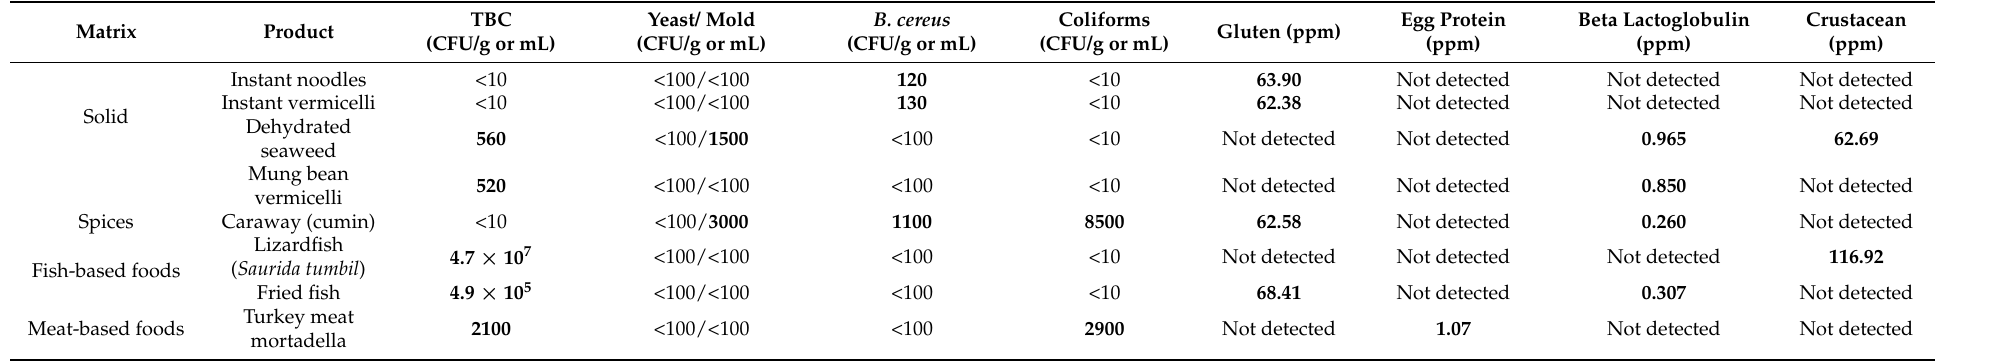
Table 7. Products displaying both microbiological and allergenic